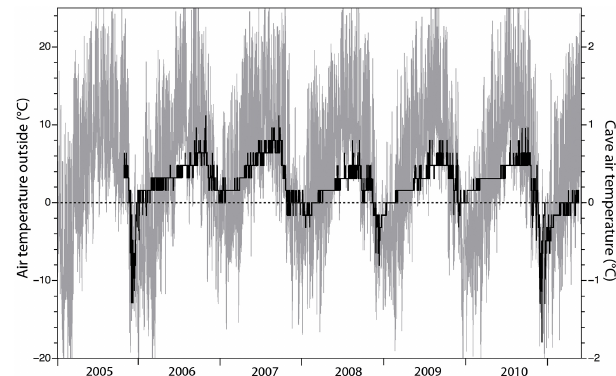
Figure 5. The air temperature near the lower end of MSK Cave (black) mirrors the outside temperature changes (grey) until about November; afterwards the cave air temperature for most of the years is decoupled from the outside air, suggesting that snow clogs the entrance during winter. The outside temperature was recorded at Spannagel Hut located at 2531m 6.5km southwest of MSK